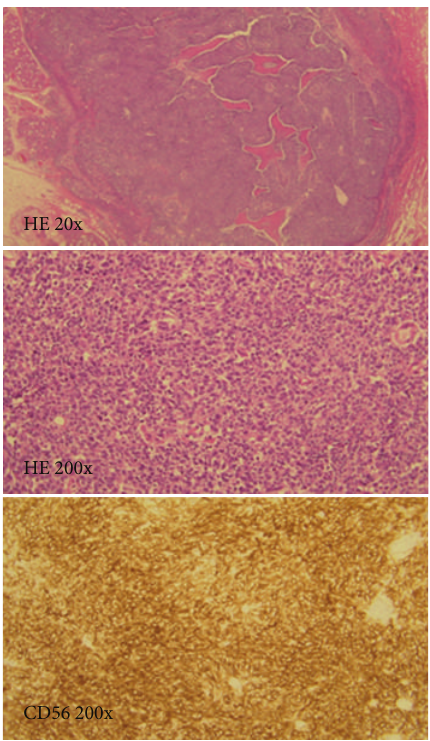
Figure 4: The SmCC component of the tumor. The second com- ponent was composed of small round cancer cells, and CD56 was highly